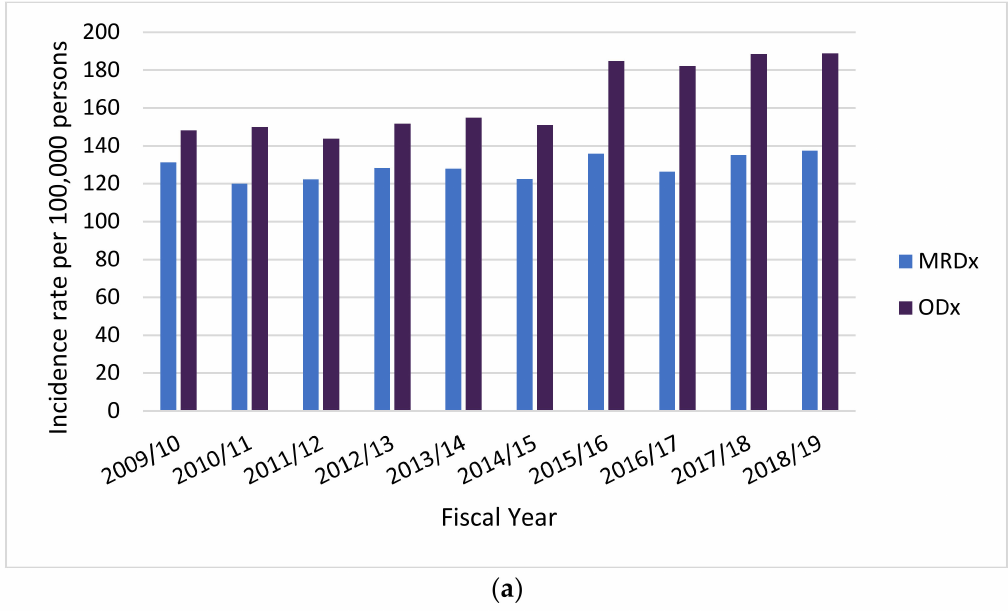
Figure 1. Incidence rates of acute-care hospitalization for all-cause community-acquired pneumonia, by age group, in fiscal years 2009–2018, Canada (excluding Quebec). Incidence rates were higher in older age groups compared to younger age